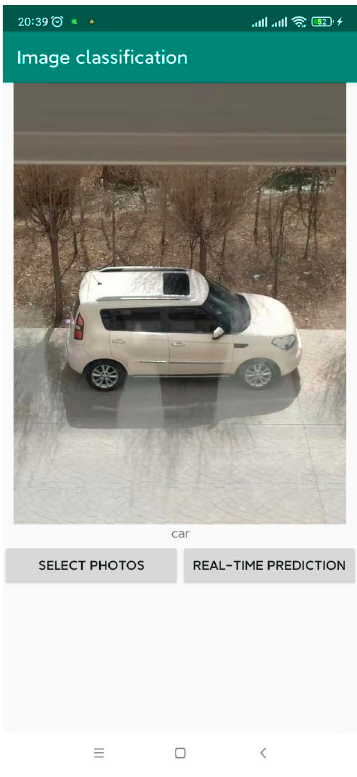
Figure 5. Image classification effect based on mobile terminal.